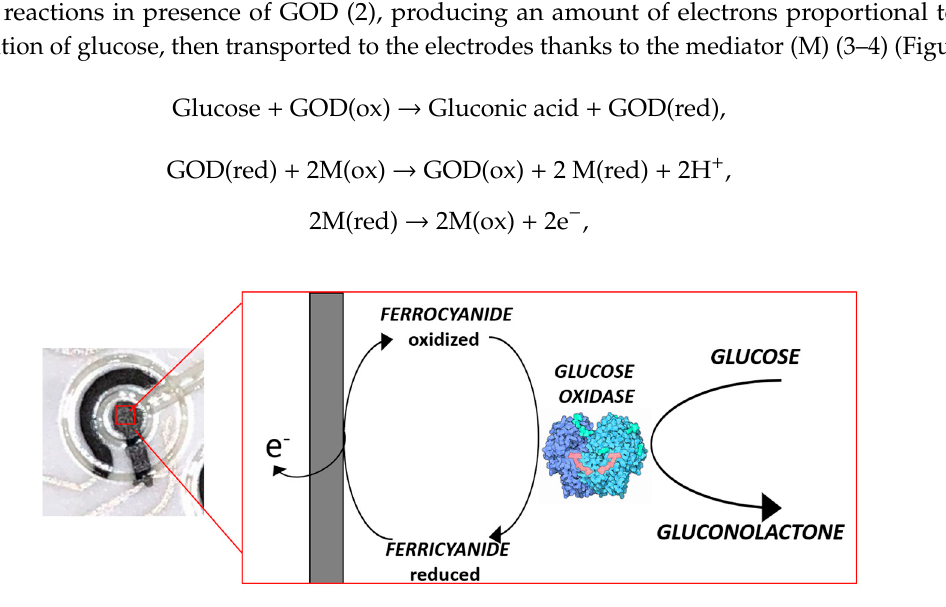
Figure 6. Mechanism of enzyme-mediated glucose sensing.